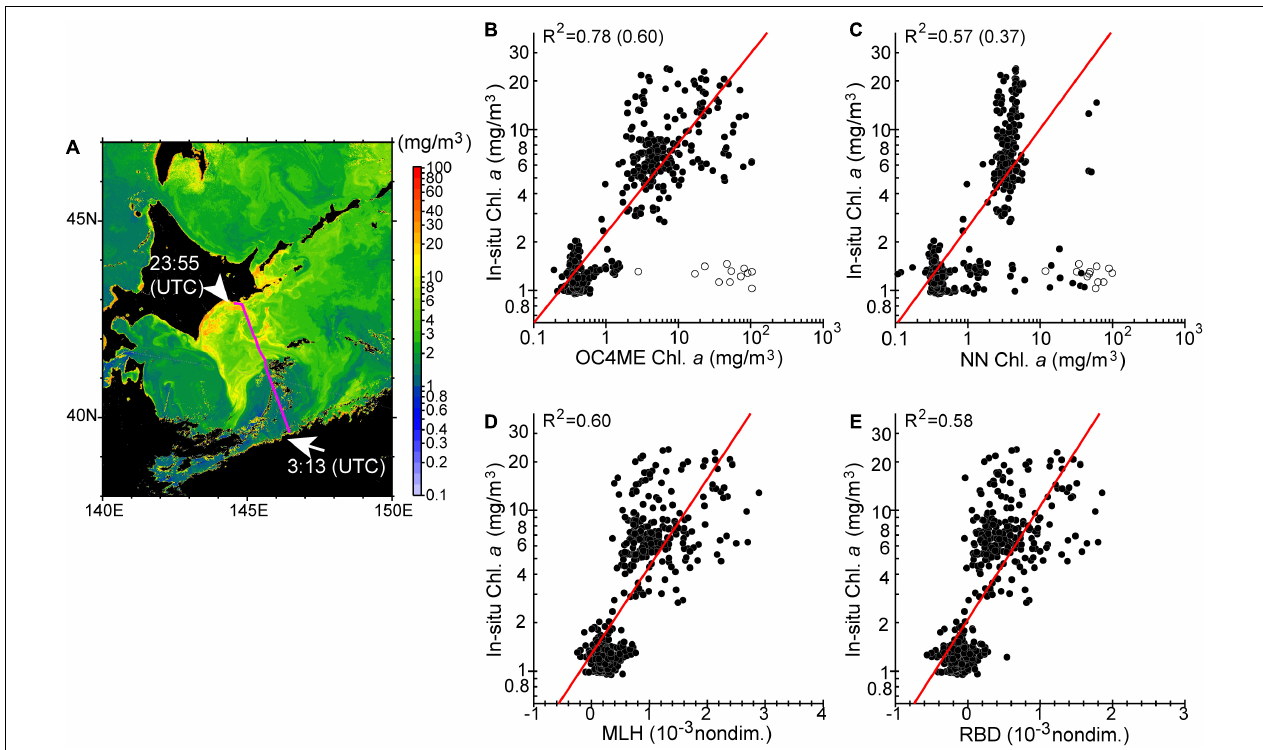
FIGURE 8 | (A) Chlorophyll- a concentrations on 9 October, 2021, derived from the maximum band ratio semi-analytical algorithm (OC4ME) and corrected by the regression equation shown in Table 1 . The magenta line represents the ship track from 0313 (UTC) to 2355 (UTC) on the same day. Scatter plots show surface chlorophyll- a concentrations along the ship track versus (B) OC4ME-derived chlorophyll- a concentrations, (C) Neural network (NN)-derived chlorophyll- a concentrations, (D) maximum line height (MLH), and (E) red-band difference (RBD). Coefficients of determination are shown in the top left-hand corner of each panel. For (B,C) , coefficients of determination shown in parenthesis were estimated when data points with large deviations around the edges of clouds (indicated by open circles) were not